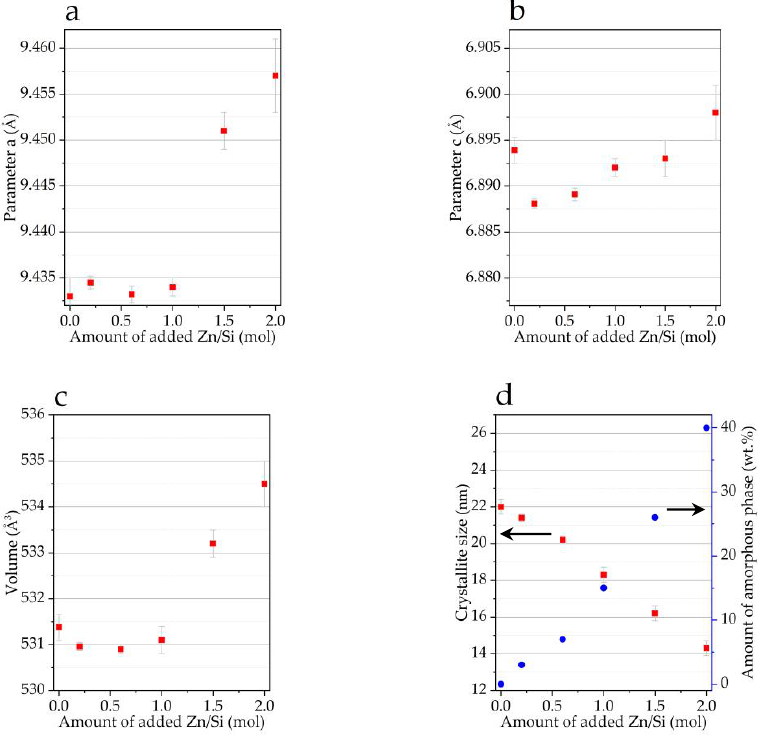
Figure 4. Dependence of lattice parameters ( a , b ), volume ( c ), and crystallite size of the HA phase and amount of the amorphous phase ( d ) on the dopant concentration. The duration of synthesis for all samples was 40 min. The left arrow indicates the assignment of red squares to the “ Crystallite size ” axis, and the arrow right indicates the assignment of blue dots to the axis “ Amount of amor- phous phase ” . amorphous